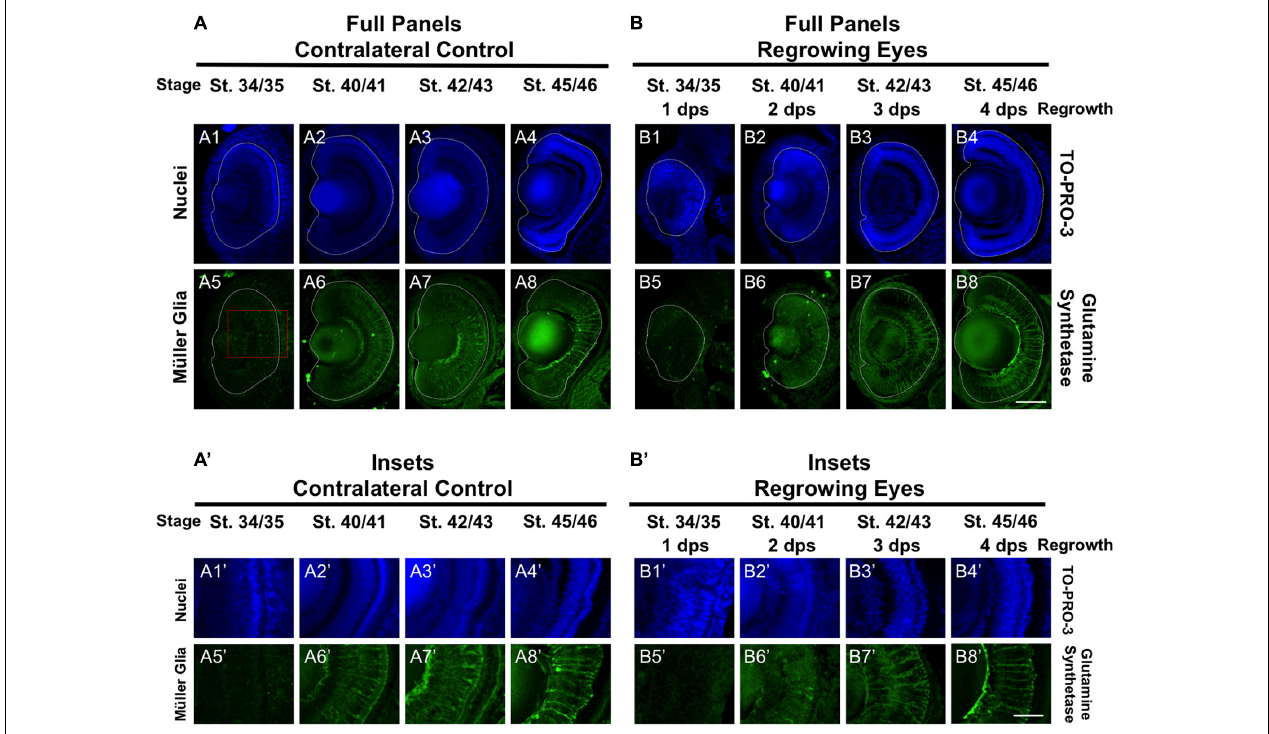
FIGURE 5 | Regrown eyes regain Müller glia differentiation by 4 dps. Images shown are immunostained, transverse sections at four developmental timepoints corresponding to 1, 2, 3, and 4 days post surgery (dps). (A,B) Regrown eyes show differentiation of Müller glial cells beginning at 2 dps. However, proper patterning of Müller glial cells is delayed in the regrowing eyes when compared to the contralateral control eyes until 4 dps. White dashed lines delineate each eye. (A’,B’) Images shown in panels A’ and B’ correspond to the region shown in the inset box in panel A5 for the corresponding A or B panel at high magnification. Blue color indicates nuclear staining (TO-PRO-3). Green color indicates anti-Glutamine Synthetase (identifies Müller glial). Sample sizes: 1 day, n = 5; 2 days, n = 5; and 3 days, n = 5. (A,B, A’,B’) Up = dorsal, down = ventral, lens is on the left. Scale bar: A,B = 100 µ m and A’-B’ = 50 µ